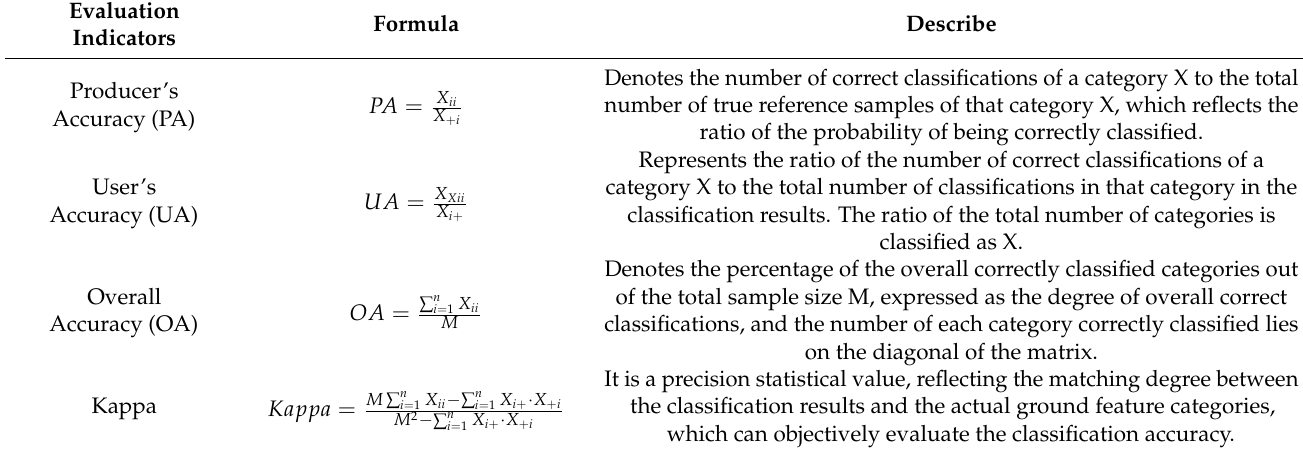
Table 6. Classification accuracy evaluation indices.